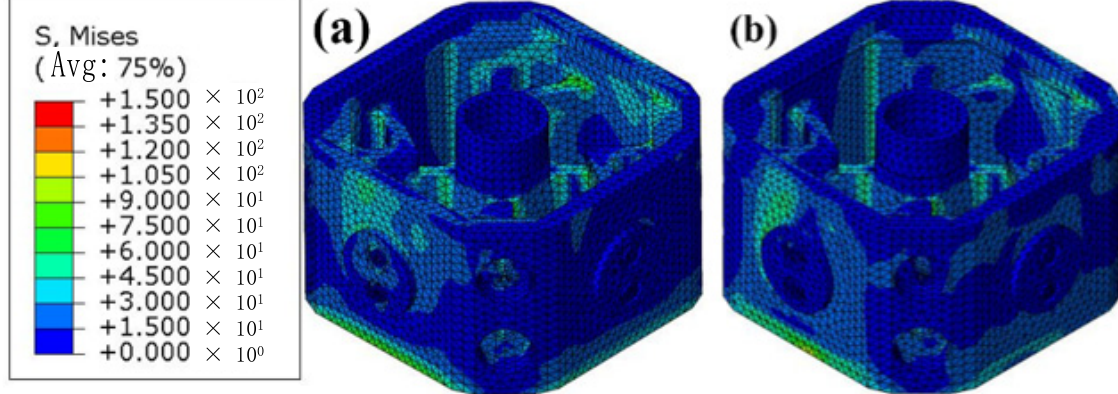
Figure 15. Strength analysis results of ( a ) original assembly block and ( b ) lightweight assembly block based on D structure filling.